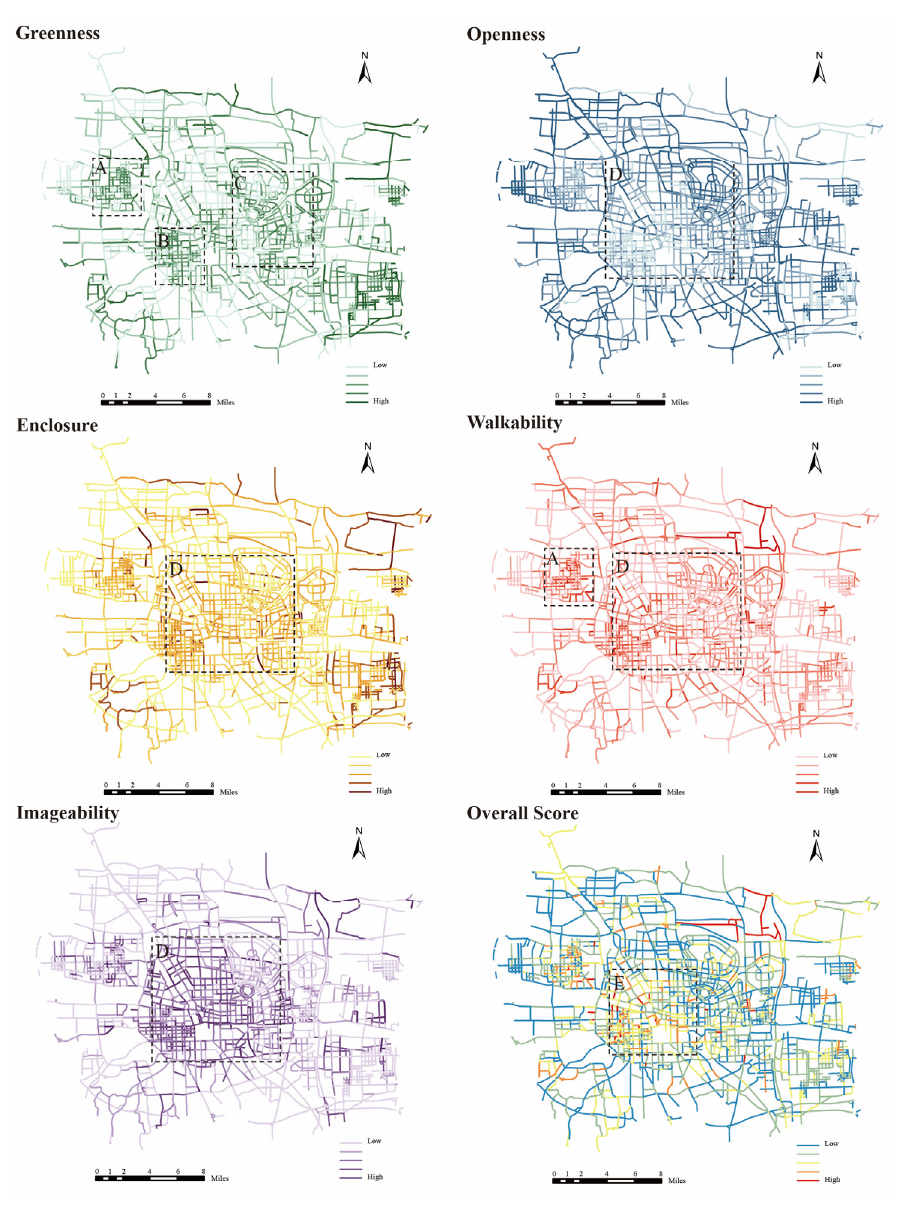
Figure 9. Human perception scores.